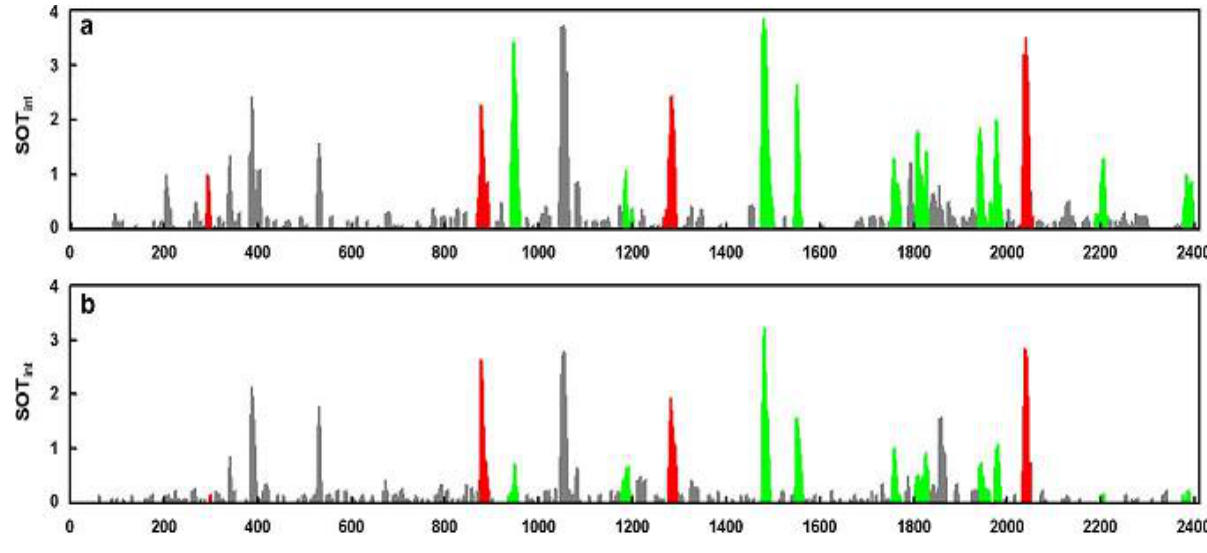
Figure 5. GC-MS/8O aromagrams of cooked hams without ( a ) and with ( b ) nitrite expressed in mean intensities of perception, each calculated from 16 individual sniffing sessions (one type of ham × 8 sniffers × 2 repeats). The breakdown of the signal into three classes of chemical origin shows the odorant zones originating from: lipid oxidation (in green), sulfur compound degradation (in red) and unspecified origins (in grey). (reprinted from [75] with permission from